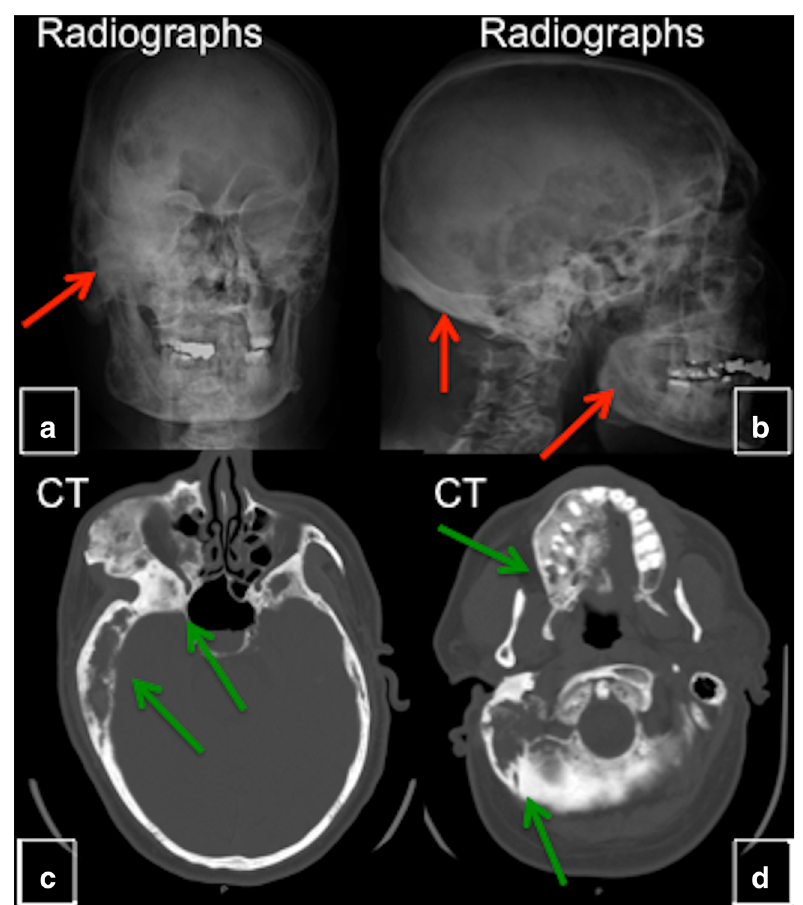
(FD). CT imaging is the modality of choice and superior to radiographs in delineating morphological changes in bone.